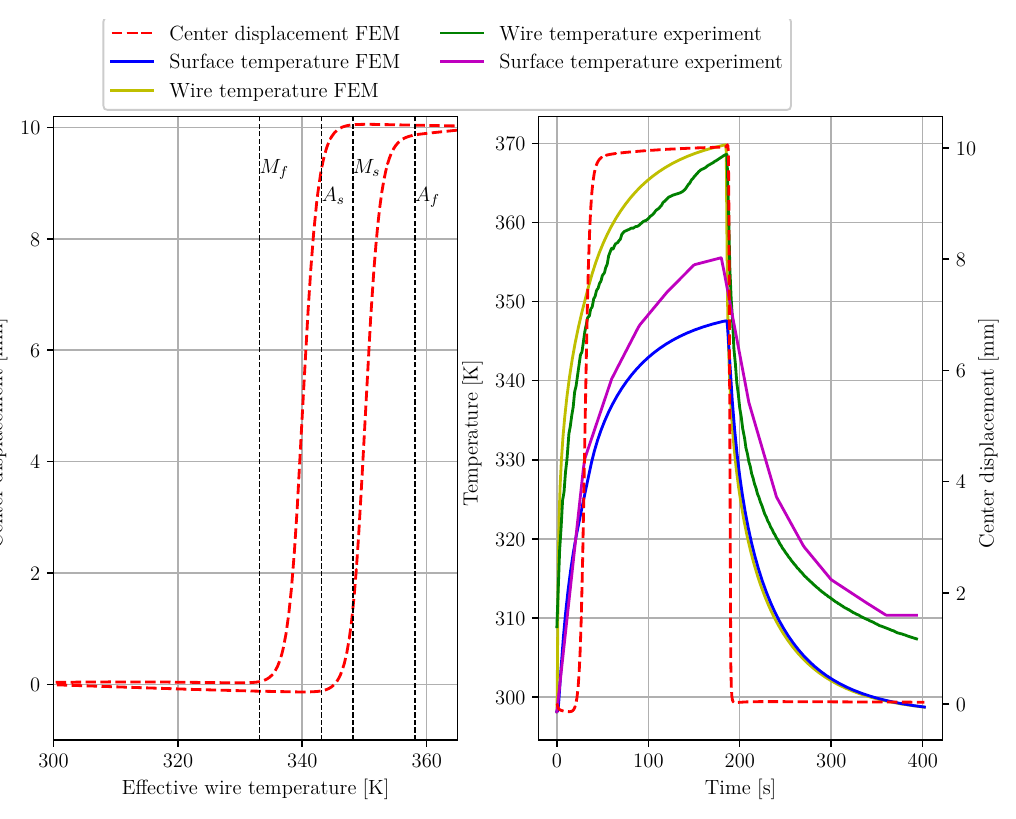
Figure 4. Comparison of the experimental and simulation results without an ice layer on the matrix surface.